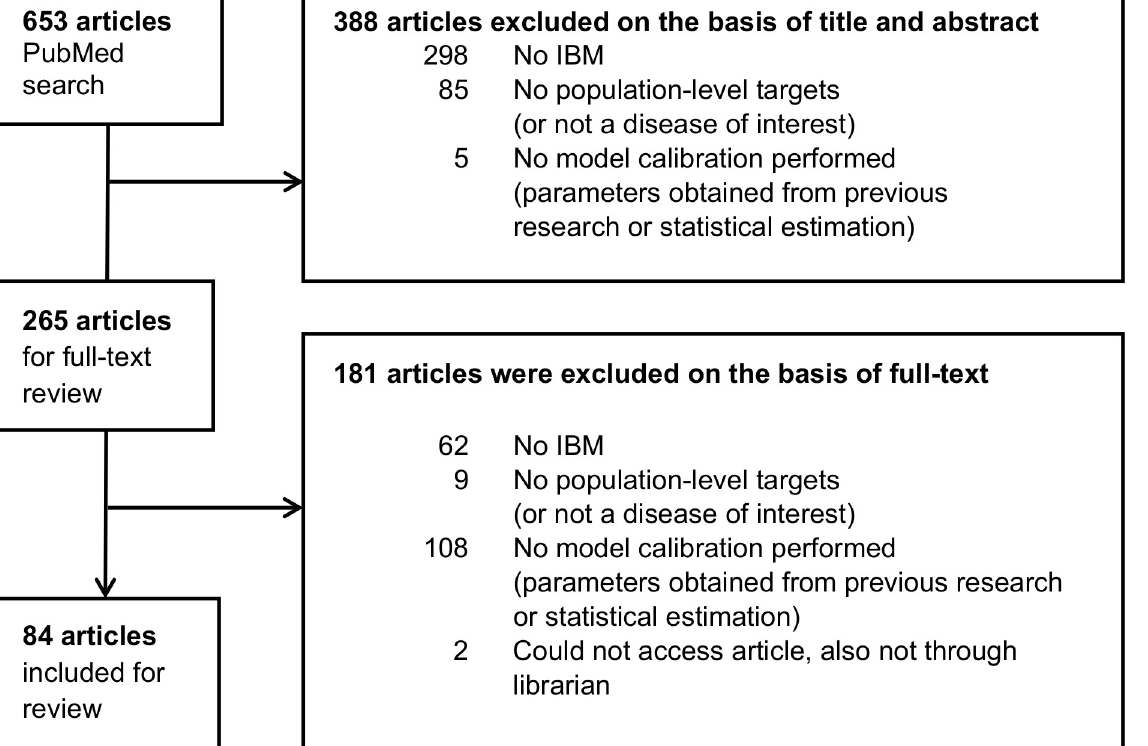
PLOS Computational Biology | https://doi.org/10.1371/journal.pcbi.1007893 May 11,